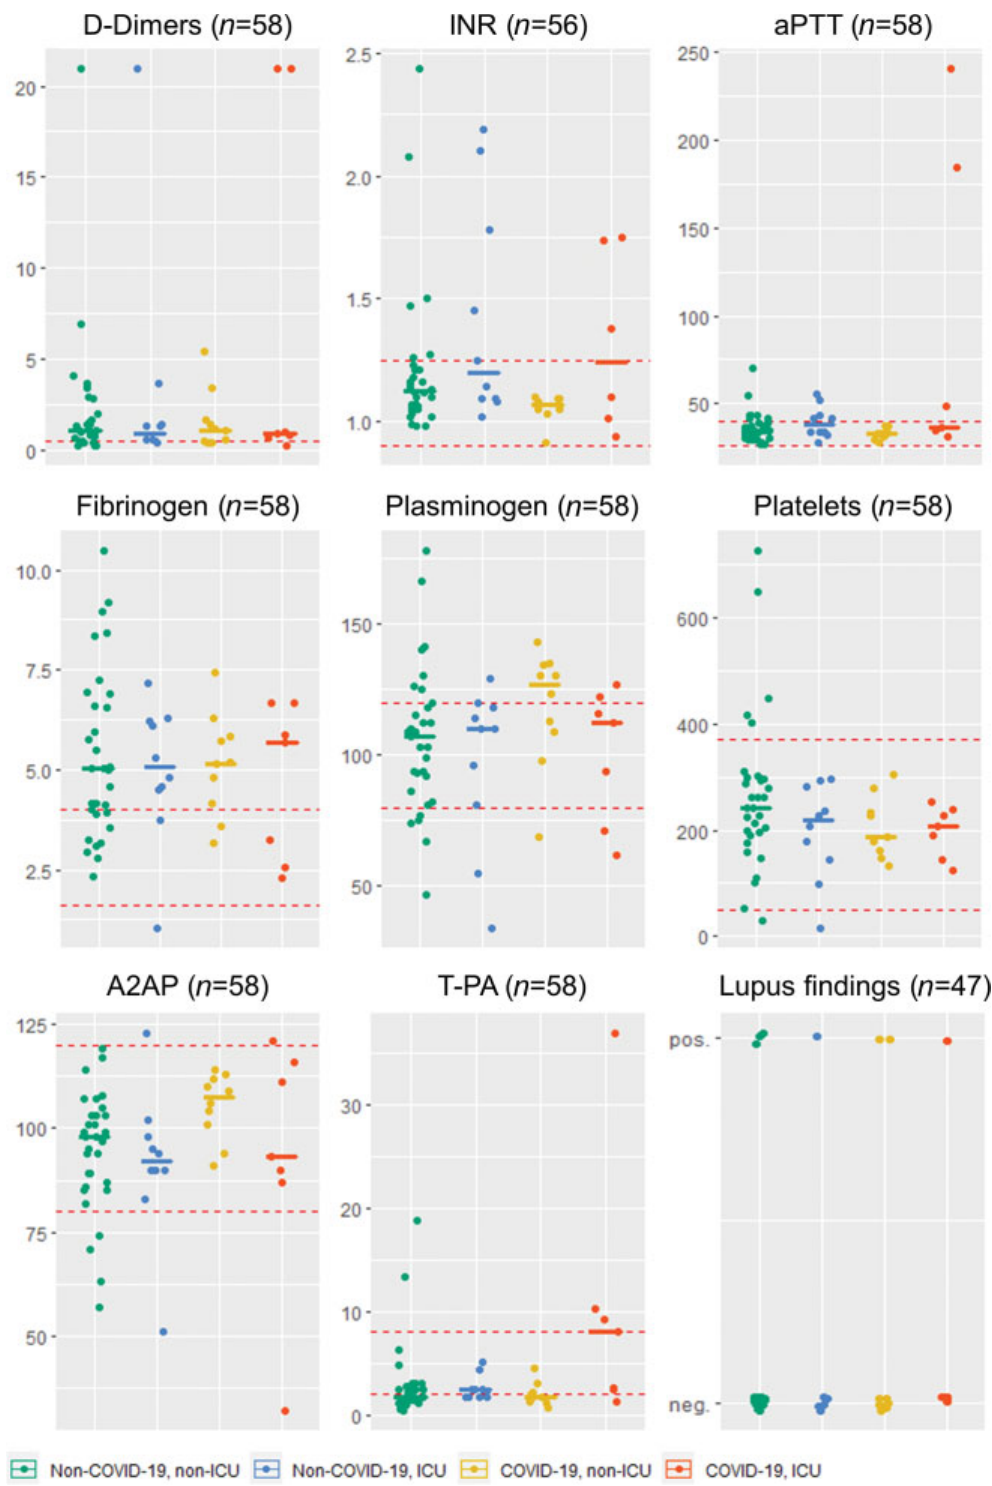
Fig.2 Jitter plotofcoagulatory parameters by COVID-19 status and ICU treatment, as grouped in ► Fig.1 . Reddashedlines represent cut-offsfor reference ranges, as detailed in ► SupplementaryTableS2 . Solid bars represent the median value for each group. COVID-19, coronavirus disease 2019; ICU, intensive care